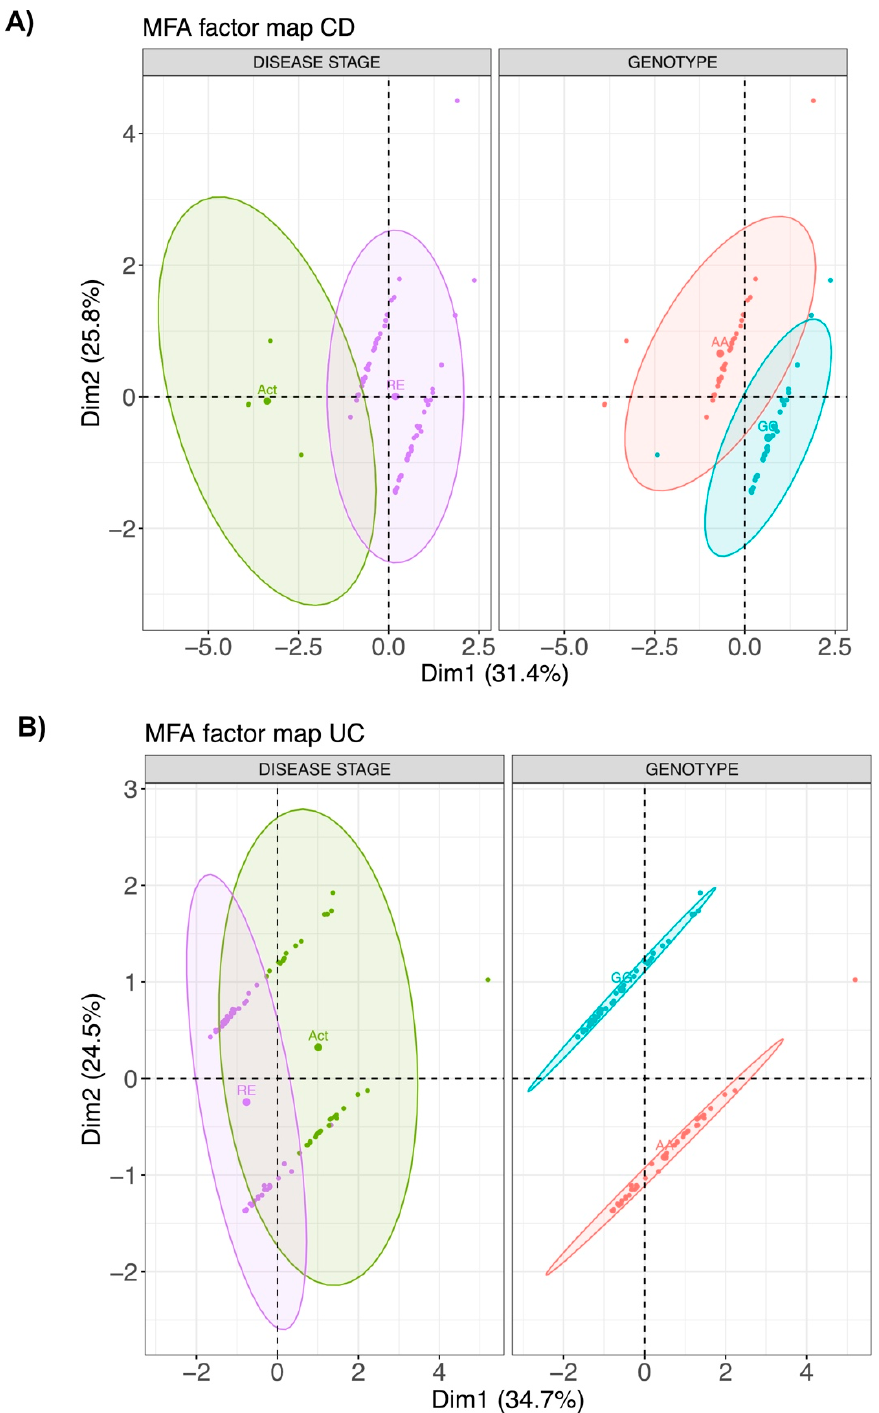
Figure 4. Multi-factorial analysis (MFA) of 27 cytokines measured in serum from both CD ( A ) and UC ( B ) patients. Levels of various cytokines were determined in blood samples from CD and UC patients in active (Act) or remission (RE) state in both wild-type and variant using ELISA.